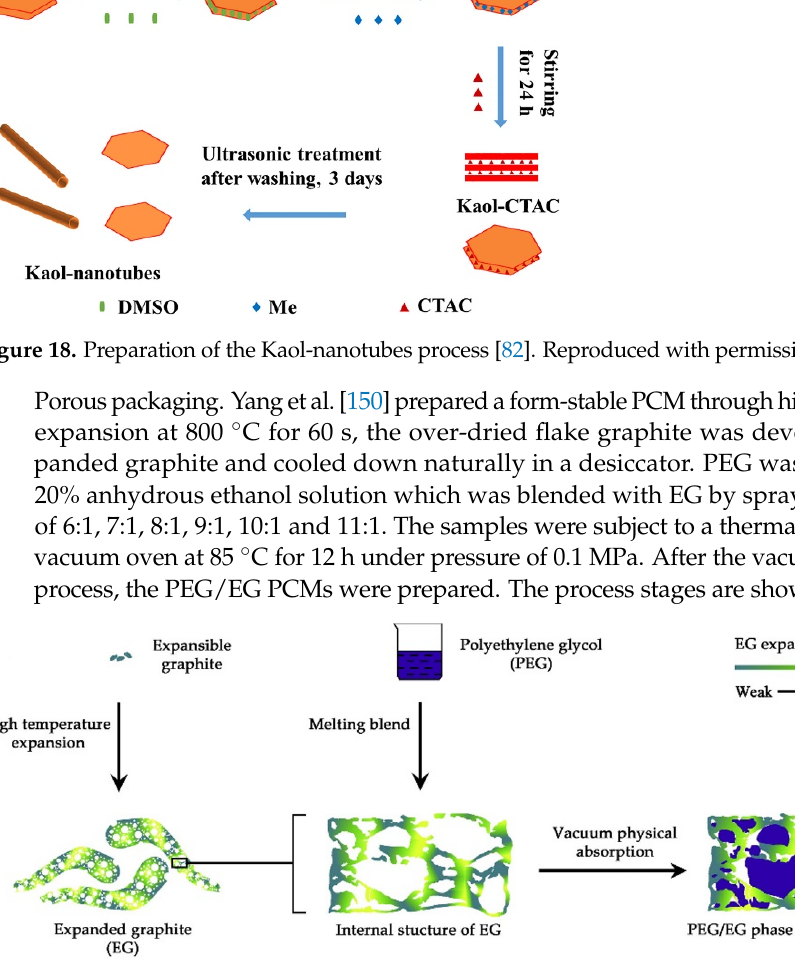
Figure 19. Preparation of PEG/EG PCM [150]. Reproduced with permission from Elsevier.